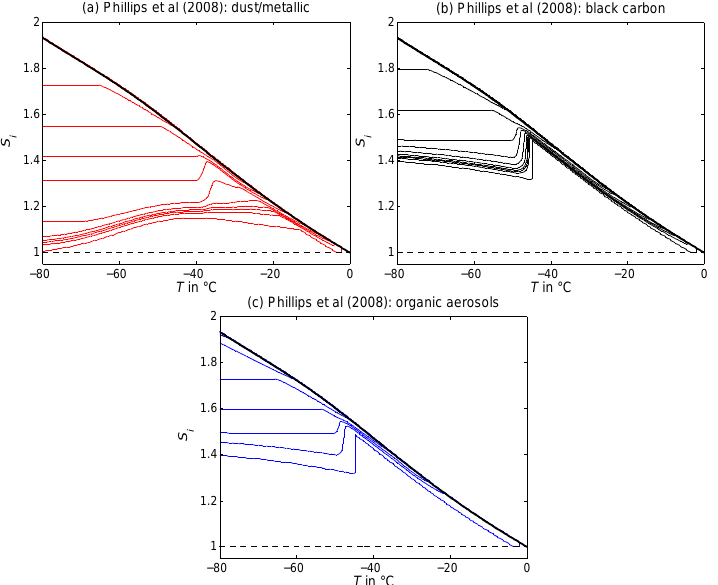
Fig. 20. Equivalent INAS densities for deposition and condensation nucleation as parameterized by Phillips et al. (2008): (a) dust/metallic aerosols, (b) black carbon, and (c) organic aerosols. The isolines correspond to (from bottom to top) ˜ n s (S i ,T ) = 1, 1 × 10 8 , 2 × 10 8 , 3 × 10 8 , 5 × 10 8 , 1 × 10 9 , 2 × 10 9 , 3 × 10 8 , 5 × 10 9 , and 1 × 10 10 m − 2 . In (b) , the highest visible isoline is 5 × 10 9 m − 2 , and in (c) , 1 × 10 9 m − 2